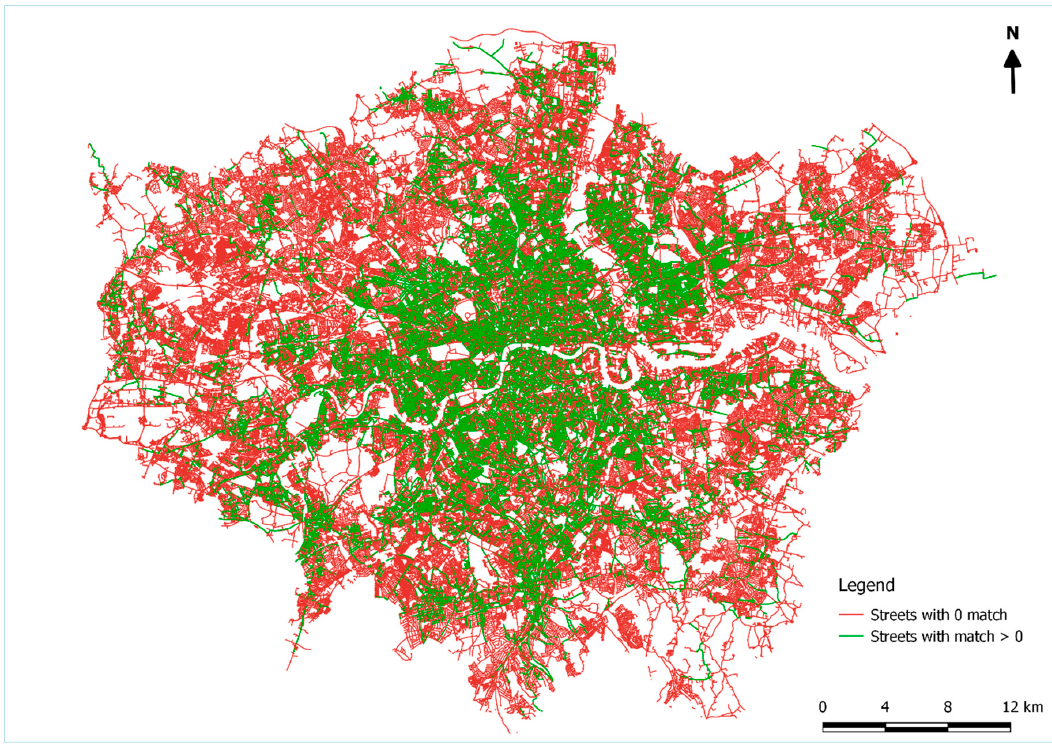
Figure 5. The street network of London in 2016, showing streets that have retained at least one identical address (green) and those that have no matches at all (red). (Source mapping: Street network from OS Open Road data).